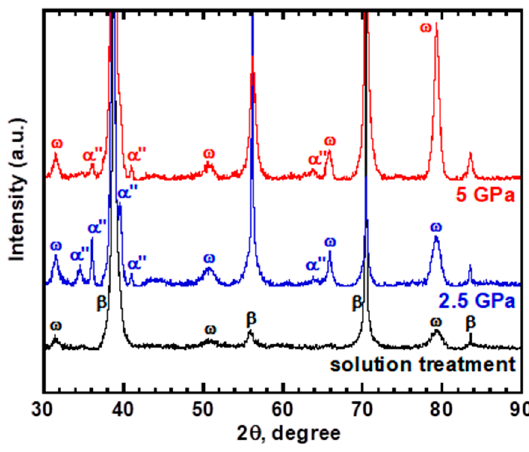
Figure 2. XRD spectrums for specimens compressed at different hydrostatic pressures.